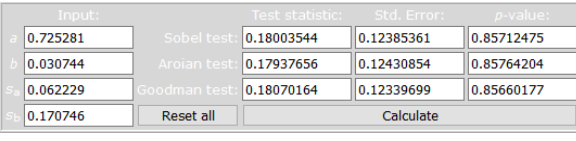
Table 8: Sobel test for Promotion Against positive word of mouth